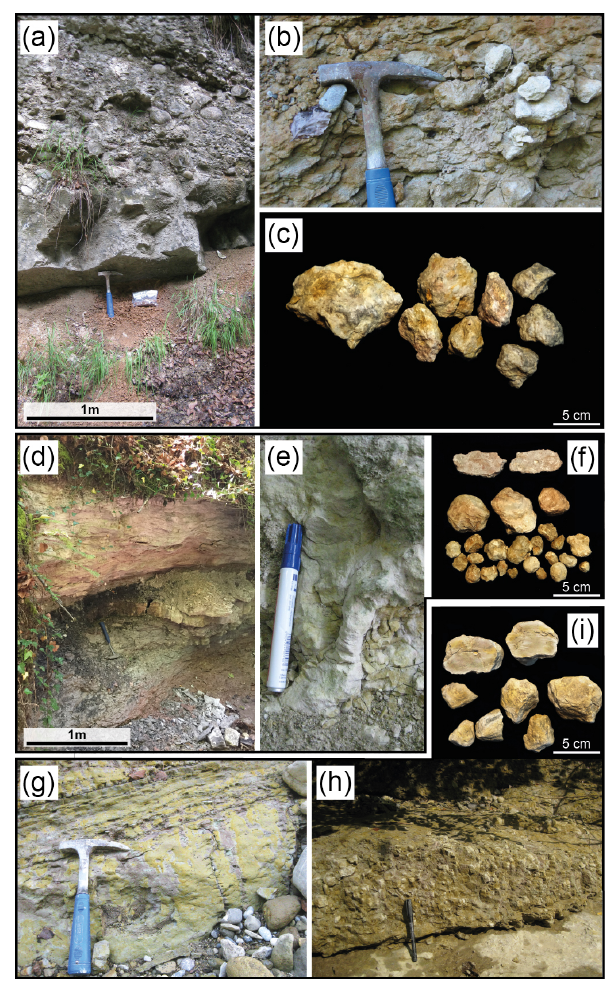
Figure 3. Outcrop conditions of the Swiss Molasse Basin sections and close-ups of sampled pedogenic carbonate nodules. (a–c) Prox- imal Fontannen section: ca. 1m thick red paleosol profile overlain by massive sandstones and conglomerates (a) . Mottled paleosol with carbonate nodules (b) and pedogenic carbonate nodules (c) . (d–f) Mid-fan Jona section: ca. 2m thick paleosol profile with in- tense mottling intersected by river channel sandstone (d) . Ca. 20cm long calcified root within a paleosol profile (e) and pedogenic car- bonate nodules (f) . (g–i) Distal Aabach section: floodplain deposits with typical strong pedogenic overprint and intense mottling in yel- low and red (g) . Paleosol abundant in carbonate nodules (h) and individual pedogenic carbonate nodules (i)